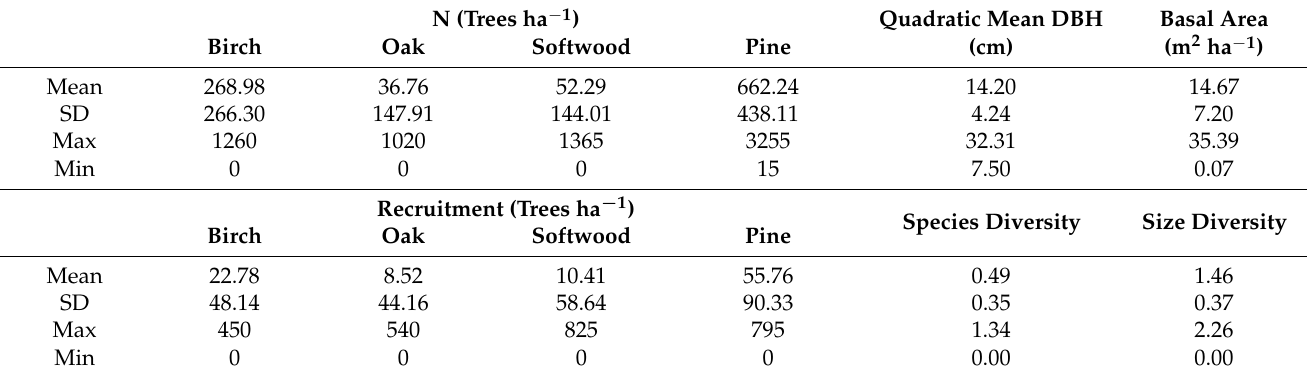
Table 2. Summary of plot data. Number of trees (N), quadratic mean DBH, basal area, size diversity, and species diversity were derived from the first inventory. Tree recruitment was produced from two inventories.